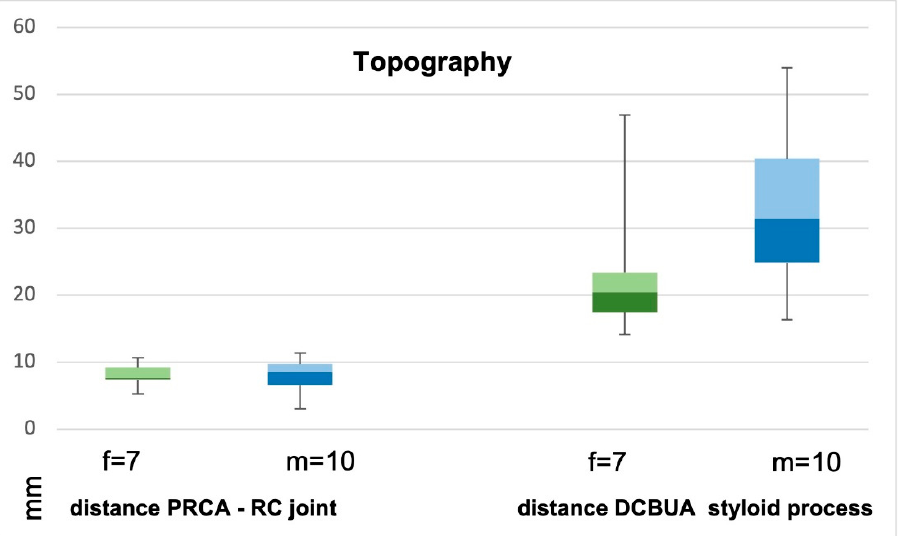
Figure 7. Distances from the palmar radiocarpal arch (PRCA) to the radiocarpal joint and from the dorsal carpal branch of the ulnar artery (DCBUA) to the styloid process of the ulna did not differ significantly between men (m) and women (f). Box plots with min/max values, median 25th and 75th percentile.